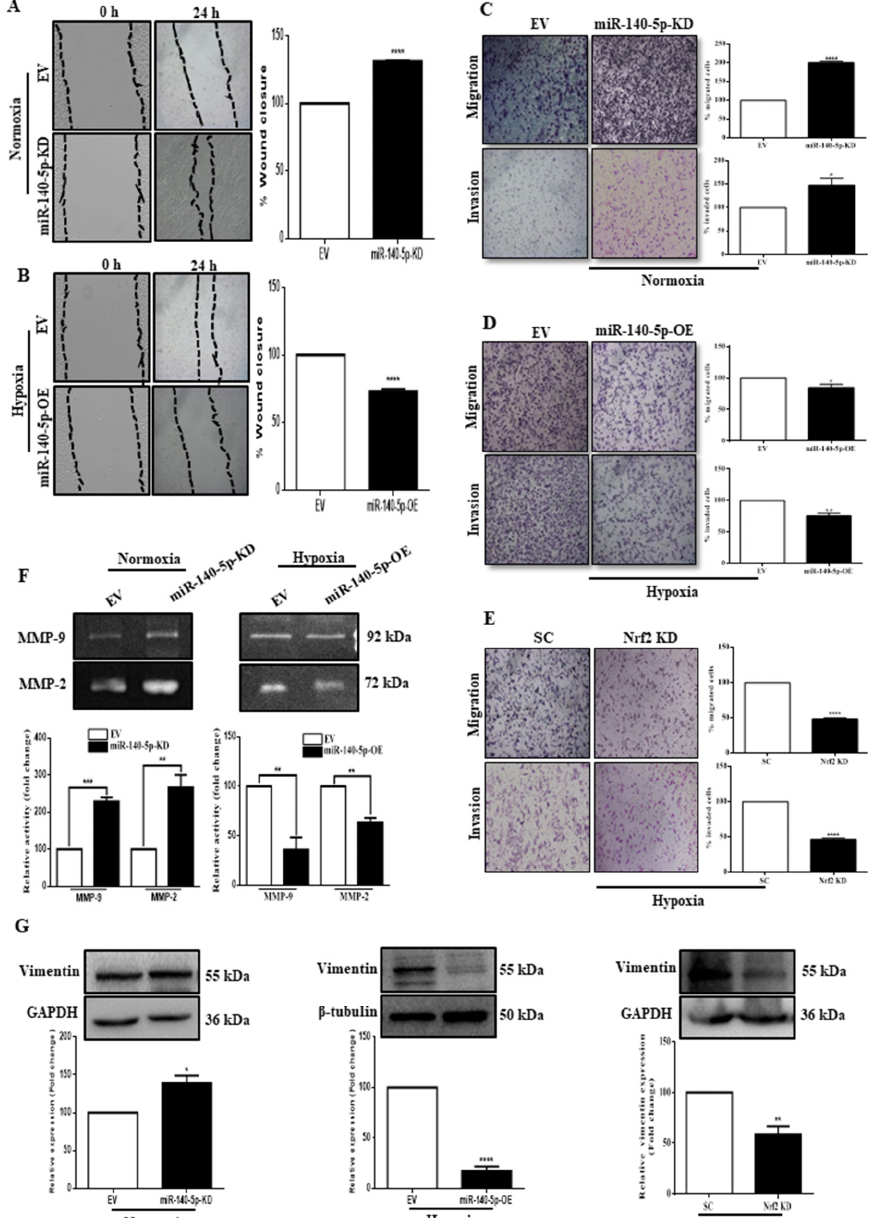
Figure 6. miR-140-5p inhibits BC cell migration and invasion. ( A , B ) Scratch wound healing assay was carried out to determine the migration ability of MDA-MB-231 cells with miR-140-5p-KD under normoxia ( A ) or miR-140-5p-OE under hypoxia ( B ) along with their EV control. ( C – E ) Transwell migration and invasion assay were performed to determine the migration and invasion ability of MDA-MB-231cells with miR-140-5p-KD under normoxia ( C ), miR-140-5p-OE under hypoxia ( D ), or Nrf2-KD under hypoxia ( E ) along with their controls. ( F ) Gelatin zymography to analyze MMP-9 and MMP-2 activity using CM from miR-140-5p-KD cells under normoxia or miR-140-5p-OE cells from hypoxia. ( G ) Analysis of vimentin expression by Western blotting in miR-140-5p-KD cells under normoxia and miR-140-5p-OE cells or Nrf2-KD cells under hypoxia. Error bars indicate mean ± SEM ( n = 3). Student’s t -tests were used to compare the means of two groups. * p < 0.05, ** p < 0.01, *** p < 0.001, and **** p < 0.0001 compared to